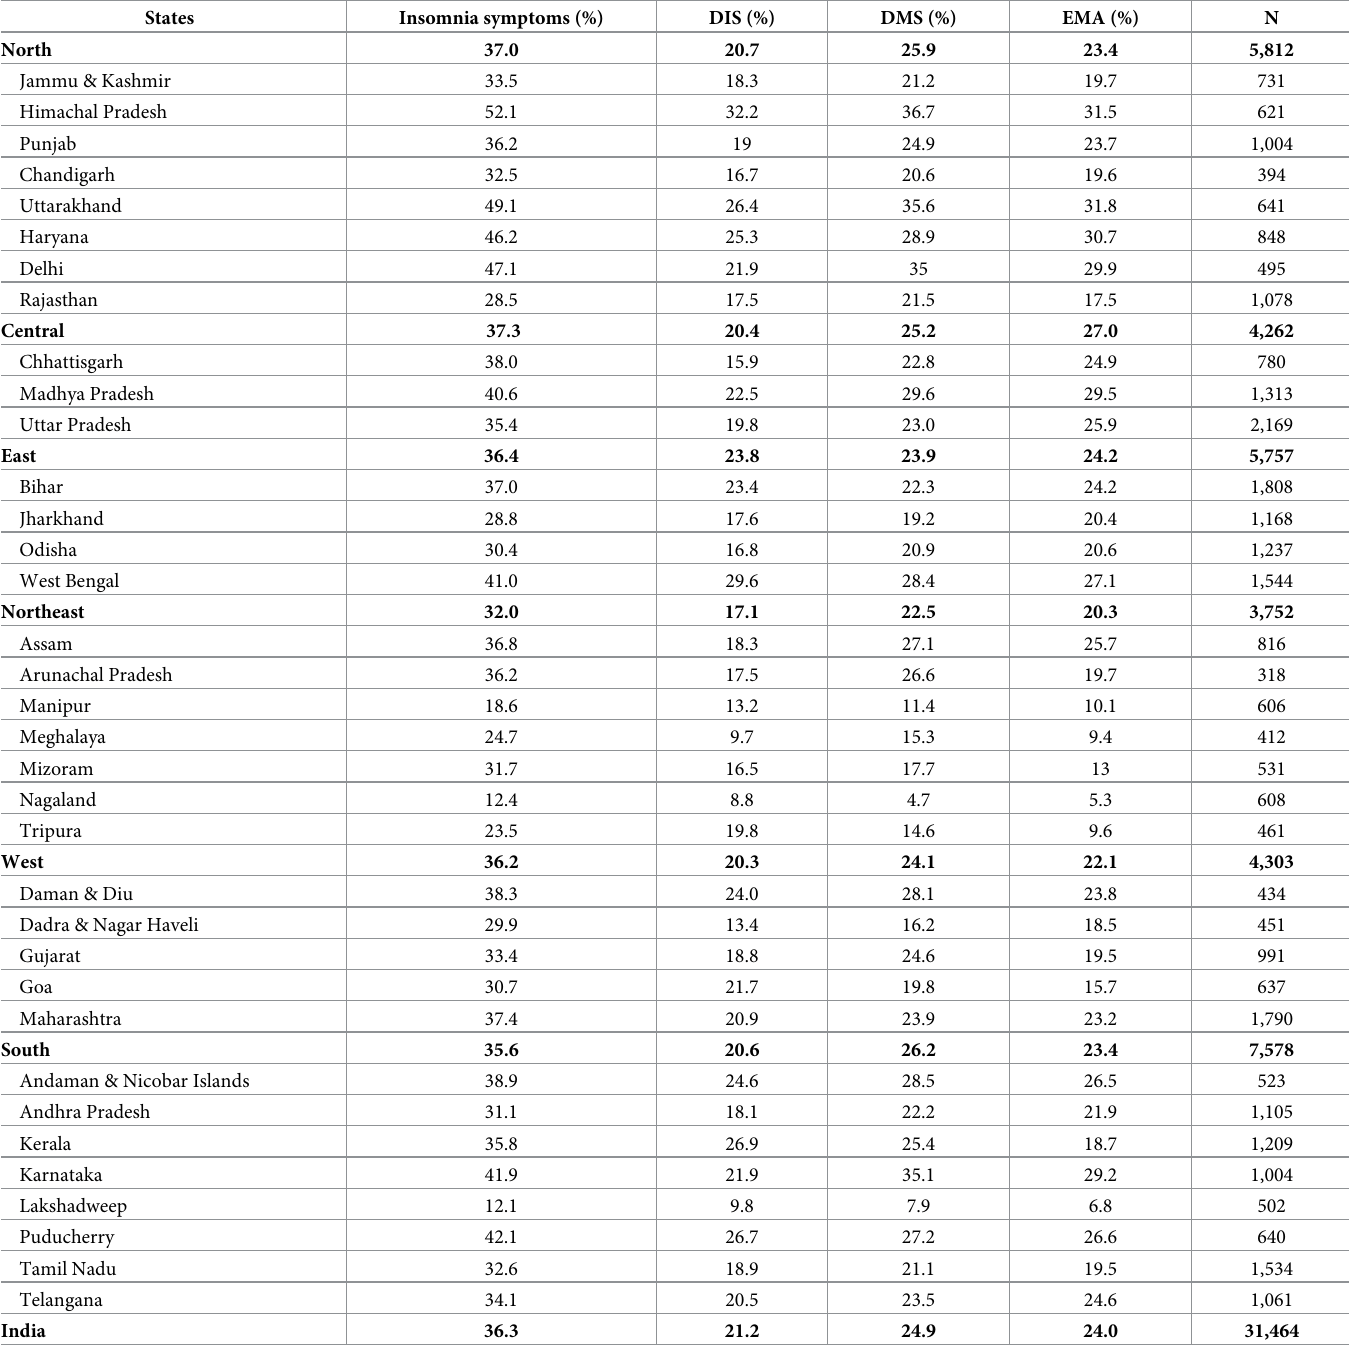
Table 1. Prevalence of insomnia symptoms among individuals aged 60 years and above by states and UTs.